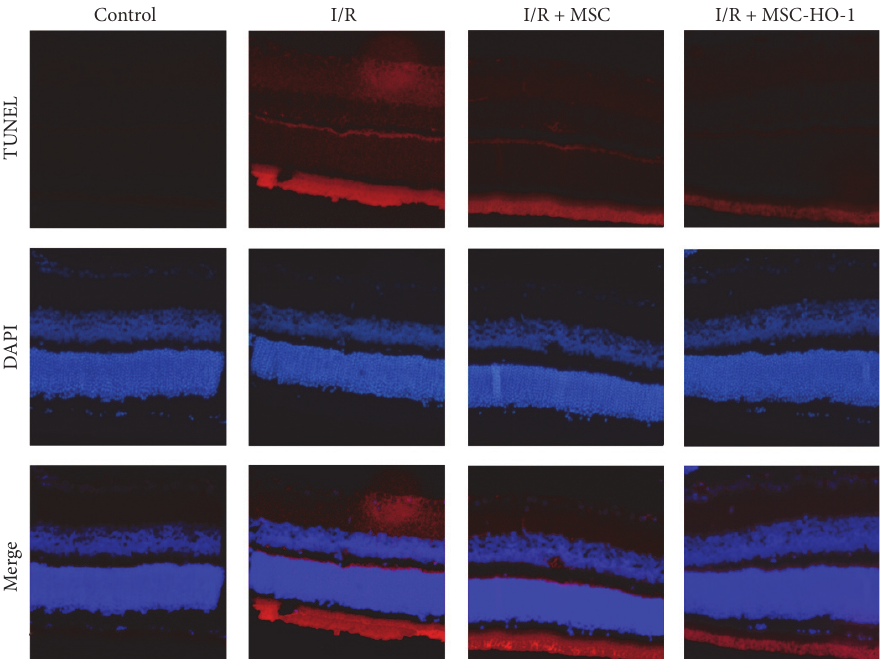
Figure 5: Effects of MSC-HO-1 on retinal cell apoptosis after I/R injury. At day 21, the retinas of control, I/R + PBS, I/R + MSC, or I/R + MSC-HO-1 group were stained utilizing TUNEL and DAPI. TUNEL staining is denoted in red and DAPI staining of nuclei in